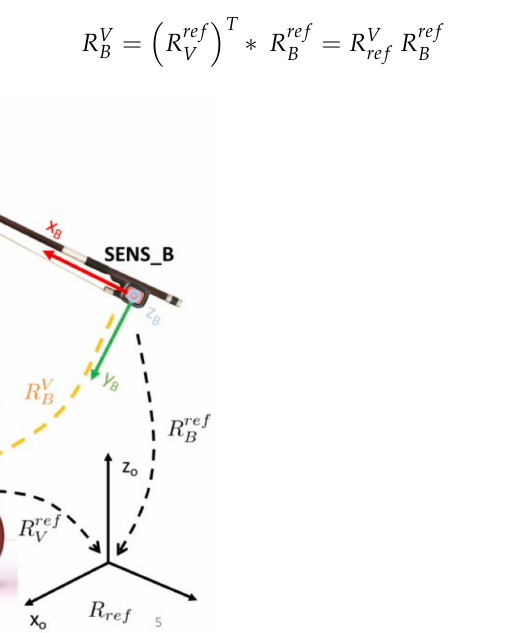
Figure 3. Arrangement of sensors on the violin and on the bow. R ref violin with respect to the reference triad, represented in black. R ref bow with respect to the reference triad, represented in